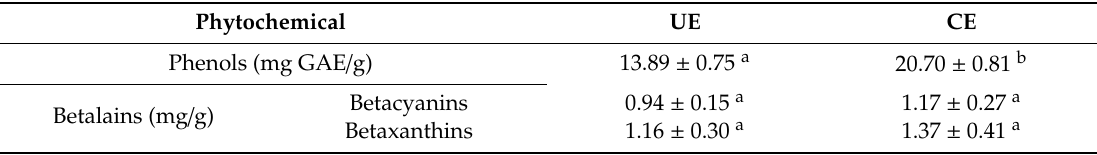
Table 1. Phytochemical content in the clarified and uncleared extract of pitaya ( Stenocereus